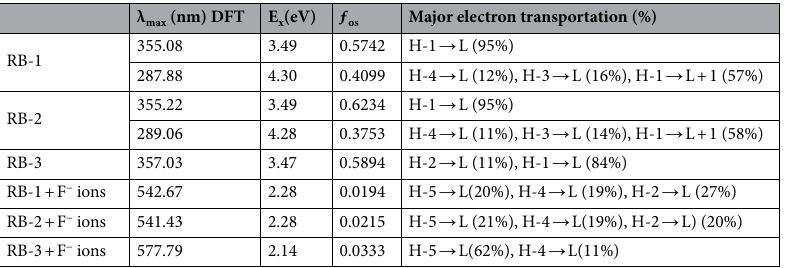
Table 4. UV–Vis spectral analysis of RB-1, RB-1 + F − ions, RB-2, RB-2 + F − ions, RB-3, RB-3 + F − ions chemosensors at TDDFT/M06/6-311G(d,p) functional. Exp., Experimental; H, HOMO; L,